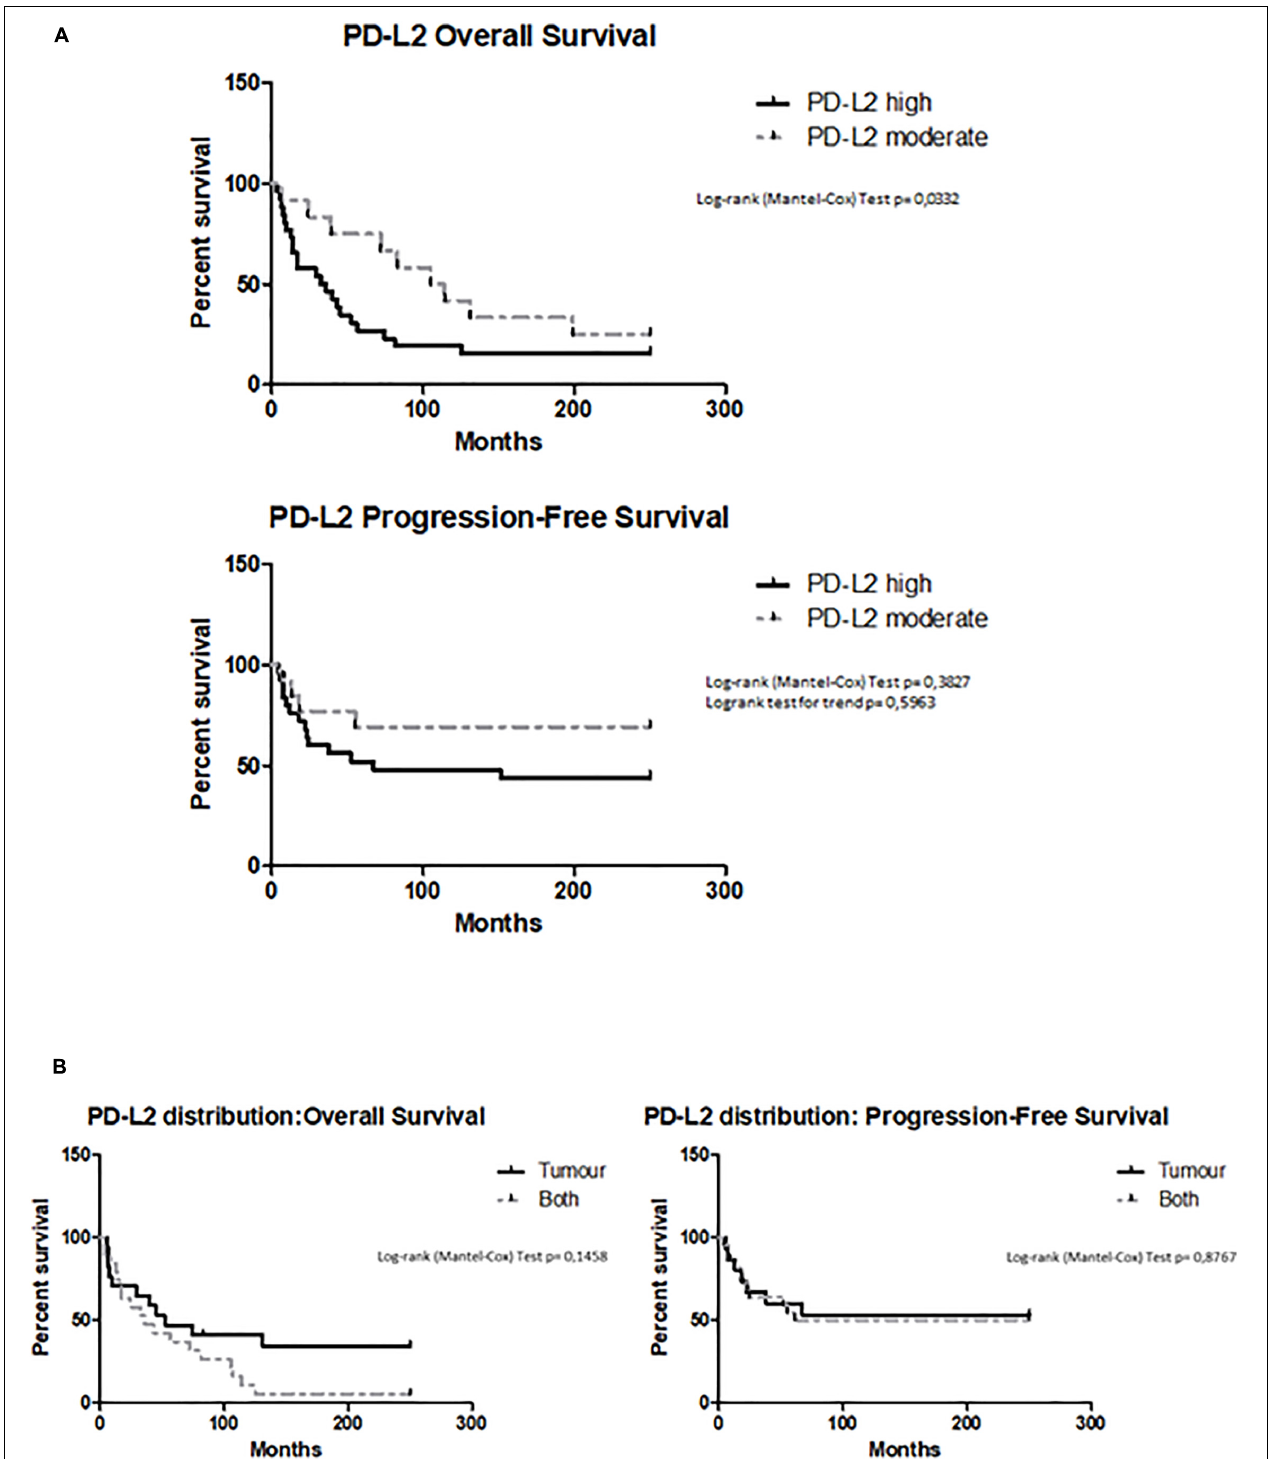
FIGURE 4 | (A) Survival of EC patients according to PD-L2 expression. Kaplan–Meier survival curves showing overall survival (OS) and PFS of EC patients. The log-rank test with corresponding p -values applies to the PD-L2 high and PD-L2 moderate curves. (B) Survival of EC patients according to the PD-L2 distribution. Kaplan–Meier survival curves showing OS and PFS of EC patients, according PD-L2 distribution inside tumoral mass (tumor, stroma, or both). The log-rank test with corresponding p -values applies to the PD-L2–tumor and PD-L2–both.